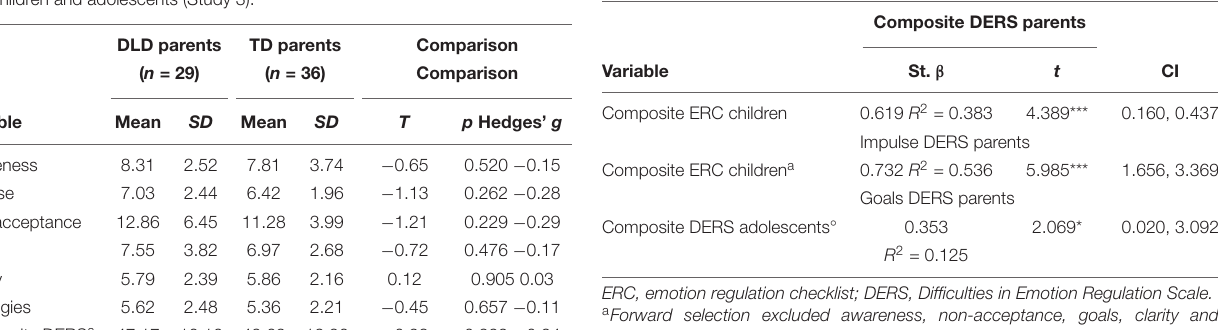
TABLE 8 | Emotion regulation scores for parents of children and adolescents with Developmental Language Disorder (DLD) and parents of a typically developing (TD) children and adolescents (Study 3).